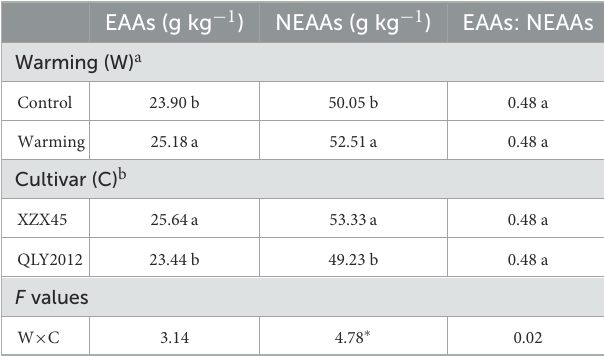
TABLE 4 The content of essential amino acids (EAAs) and non-essential amino acids (NEAAs) in milled rice as affected by warming and cultivar in